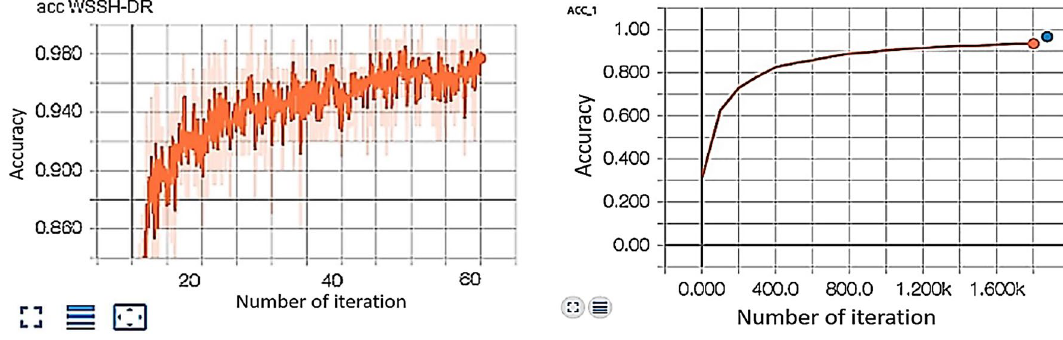
Figure 5. Accuracy of detection for WSSH-DR.